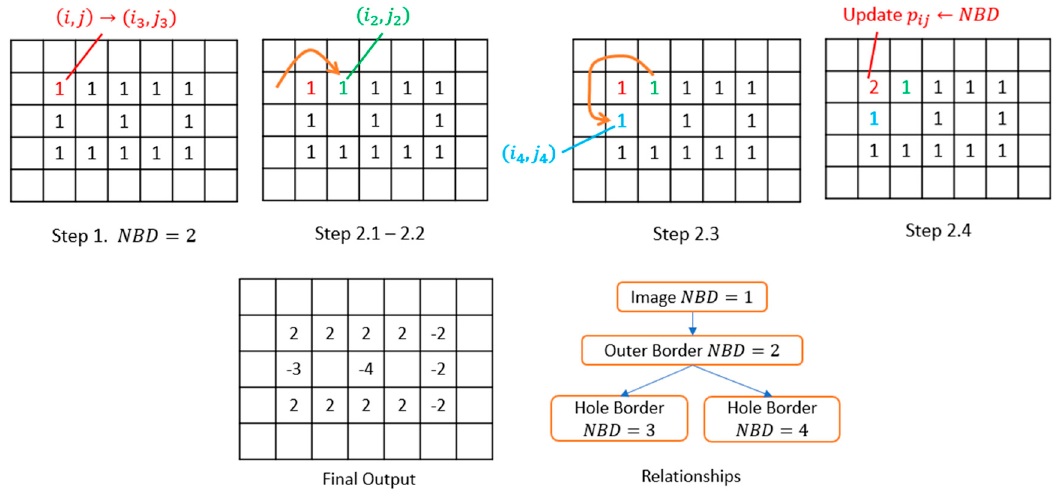
Figure 6. The introduction of Step 1, 2.1–2.4 and the introduction of the final output to the contour tracing algorithm.